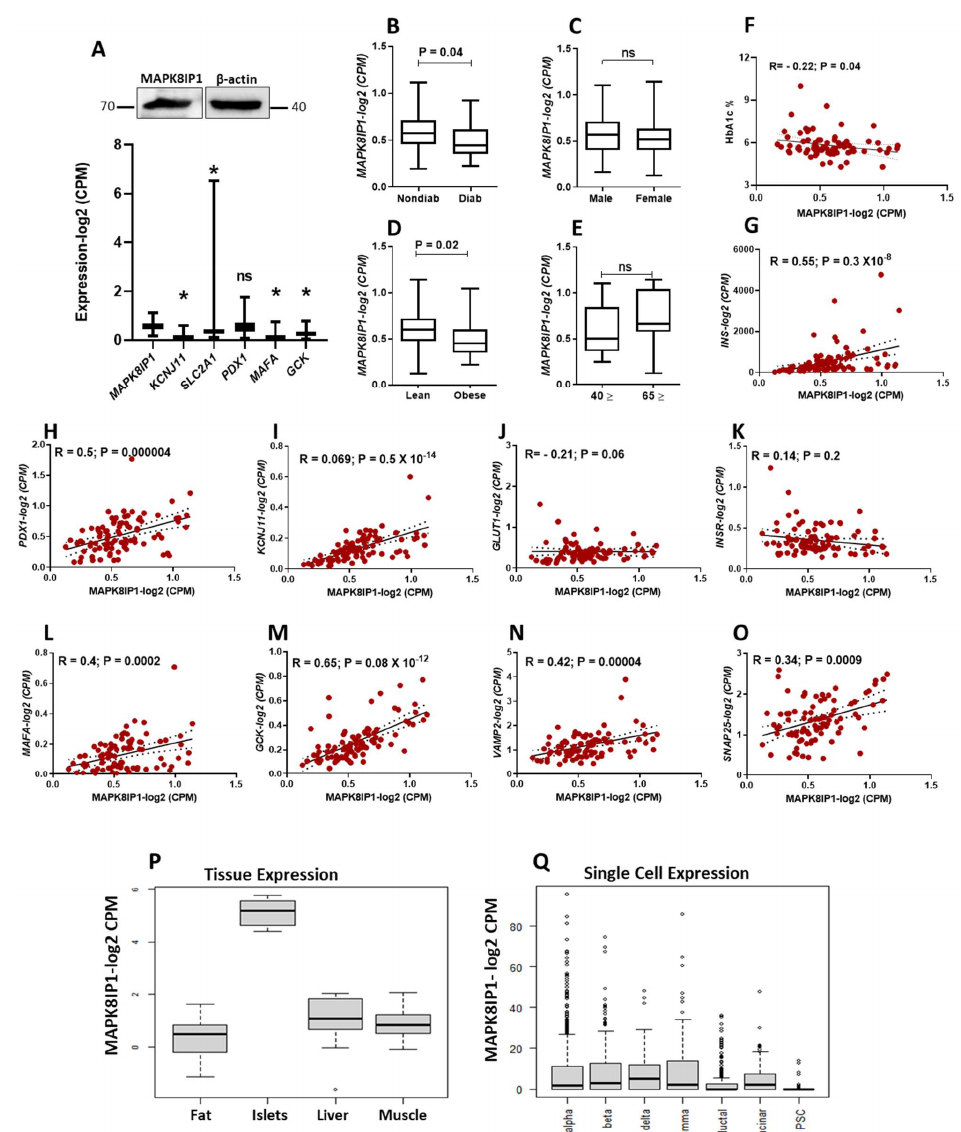
Figure 1. Expression profile of MAPK8IP1 in human pancreatic islets. ( A ) RNA-seq expression of MAPK8IP1 , KCNJ11 , SLC2A1 , PDX1 , MAFA and GCK in non-diabetic human islets ( n = 57) (lower panel). Western blot expression analysis of MAPK8IP1 in human islets obtained from non-diabetic donors ( n = 1; obtained from Prodo Lab, Aliso Viejo, CA, USA) (upper panel). ( B – E ) RNA-seq differential expression analysis of MAPK8IP1 in human islets obtained from diabetic/hyperglycemic donors ( n = 21) vs. nondiabetic/normoglycemic donors ( n = 51) ( B ), male donors ( n = 54) vs. female donors ( n = 36) ( C ), lean donors (BMI < 25; n = 39) vs. obese donors (BMI > 29; n = 20) ( D ), old donors ( ≥ 65; n = 9) vs. young donors ( ≤ 40; n = 14) ( E ). ( F – O ) Co-expression correlations of MAPK8IP1 with HbA1c ( F ), INS ( G ), PDX1 ( H ), KCNJ11 ( I ), GLUT1 ( J ), INSR ( K ), MAFA ( L ), GCK ( M ), VAMP2 ( n ), and SNAP25 ( O ) using RNA-seq expression data from human pancreatic islets. R and p values are indicated in the respective graphs. ( P ) MAPK8IP1 expression in human fat tissue ( n = 12), pancreatic islets ( n = 12), liver ( n = 12) and skeletal muscle tissues ( n = 12) obtained from the same donors using IGV data. ( Q ) MAPK8IP1 expression in sorted pancreatic cells, ductal, acinar, or PSC was obtained using IGV data. R: correlation coefficient; p : p -value. * p < 0.05; ns, not significant. Bars above histograms represent SD of the mean values. We assessed the expression using the nonparametric Mann–Whitney test for figures ( A – E ). For figure ( F – O ), we evaluated the correlations using the nonparametric Spearman’s